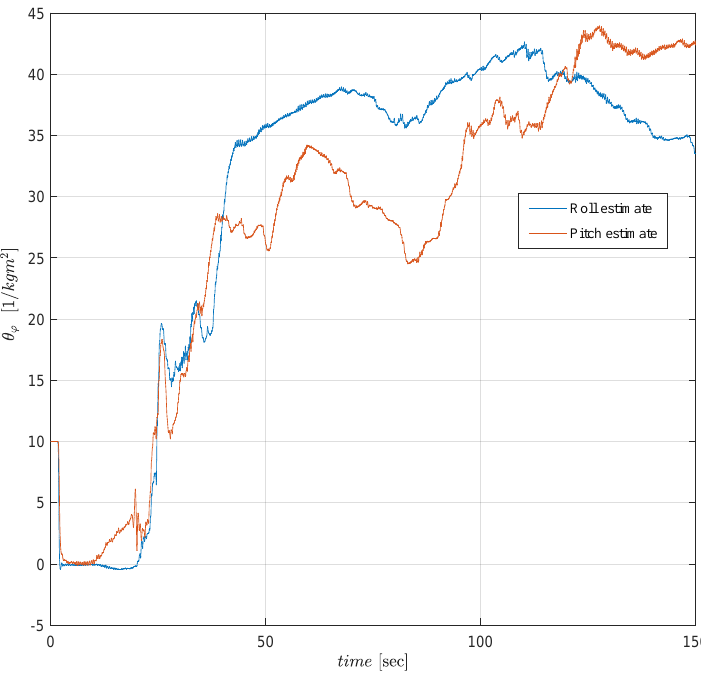
Figure 15. LS based estimate ˆ θ ϕ of the uncertain inertia parameter θ ∗ ϕ .